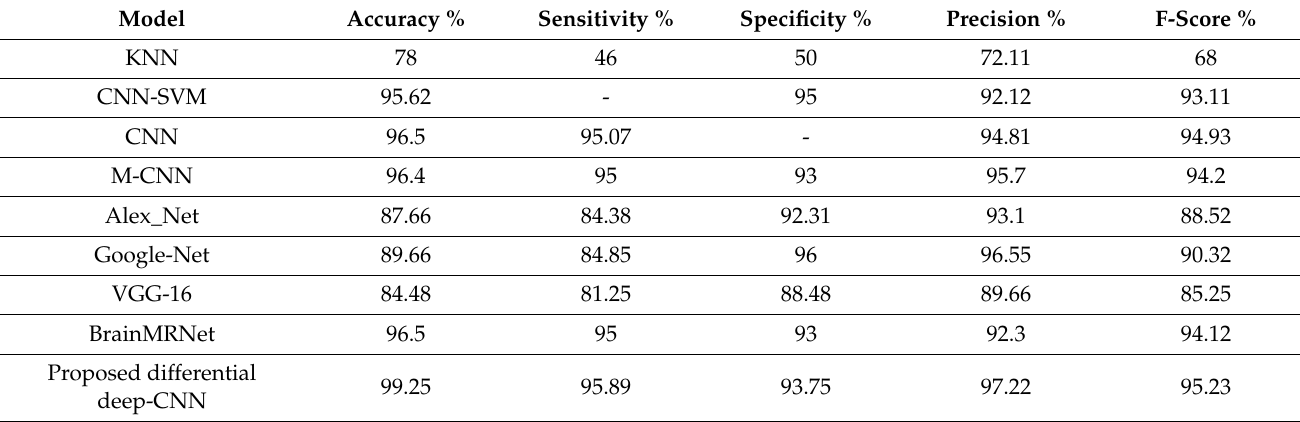
Table 2. Comparison of the results of different models with our proposed differential deep-CNN model.